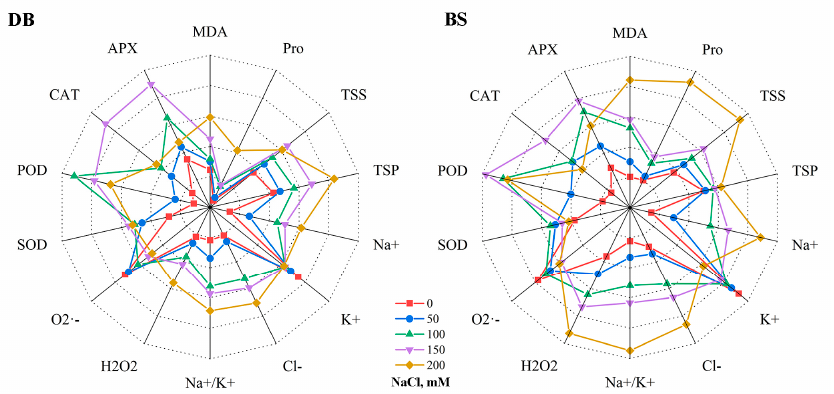
Figure 8. The radar chart of 14 indexes of H. syriacus ‘Duede Brabaul’ (DB) and H. syriacus ‘Blueberry Smoothie’ (BS) under NaCl stresses. Each point in this figure represents a specific measured value for each parameter without homogenization (see previous sections for detailed values). Due to the differences between the different parameters measured, the lengths of the different axis representations were adjusted to make the images more visible. The axis lengths and intersections are identical for the same parameters of the DB and BS. Note: MDA, malondialdehyde; Pro, proline; TSS, total soluble sugars; TSP, total soluble protein; Na + , sodium ions; K + , potassium ions; Cl − , chloride ions; Na + /K + , sodium-to- potassium ion ratio; H 2 O 2 , hydrogen peroxide; O 2 · − , inhibition of O 2 · − product activity; SOD, superoxide dismutase; POD, peroxidase; CAT, catalase; APX, ascorbate